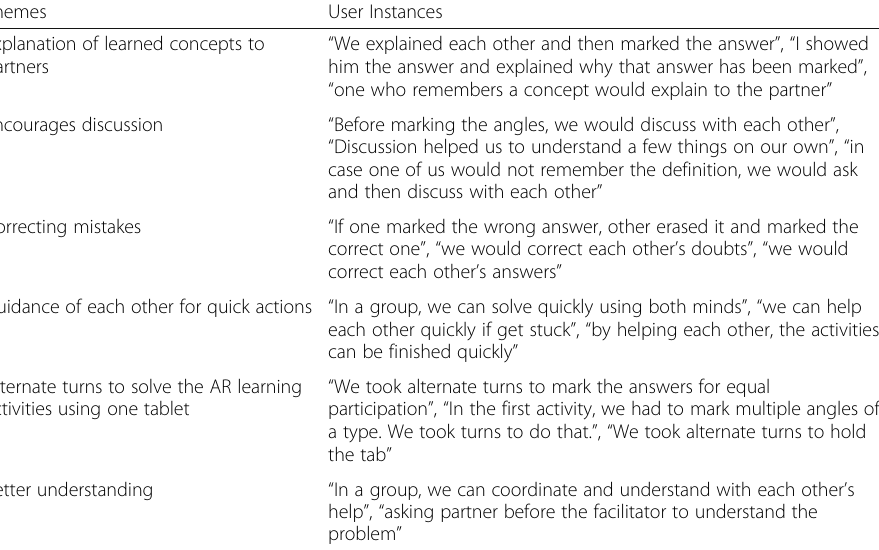
Table 2 Thematic Analysis to identify the role of collaboration as perceived by the participants